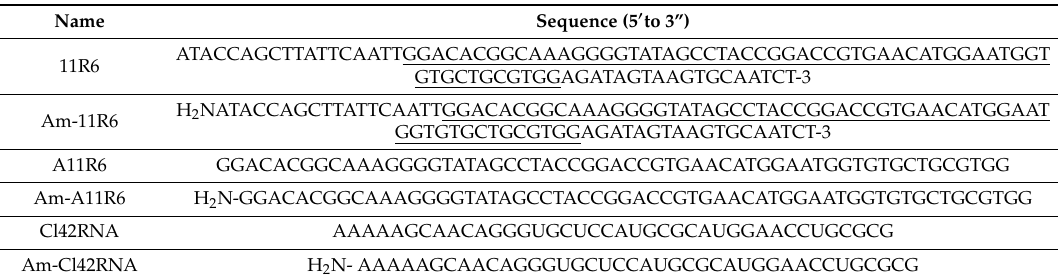
Table 1. ssDNA and RNA Aptamers Used in This